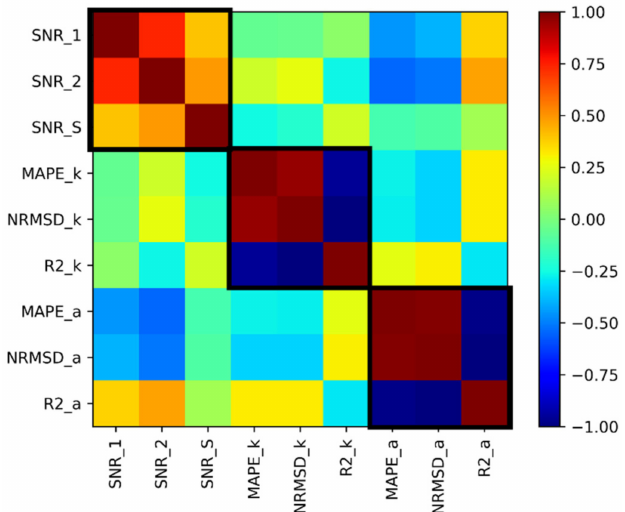
Figure 6. The matrix representing Pearson correlation coefficients between various calculated metrics. Correlations between data-based, kinematic, and dynamic groups of metrics are highlighted by black